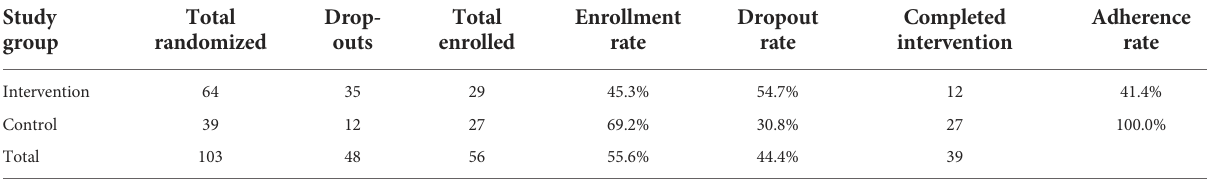
TABLE 1 Recruitment, enrollment, and retention of the EE intervention.